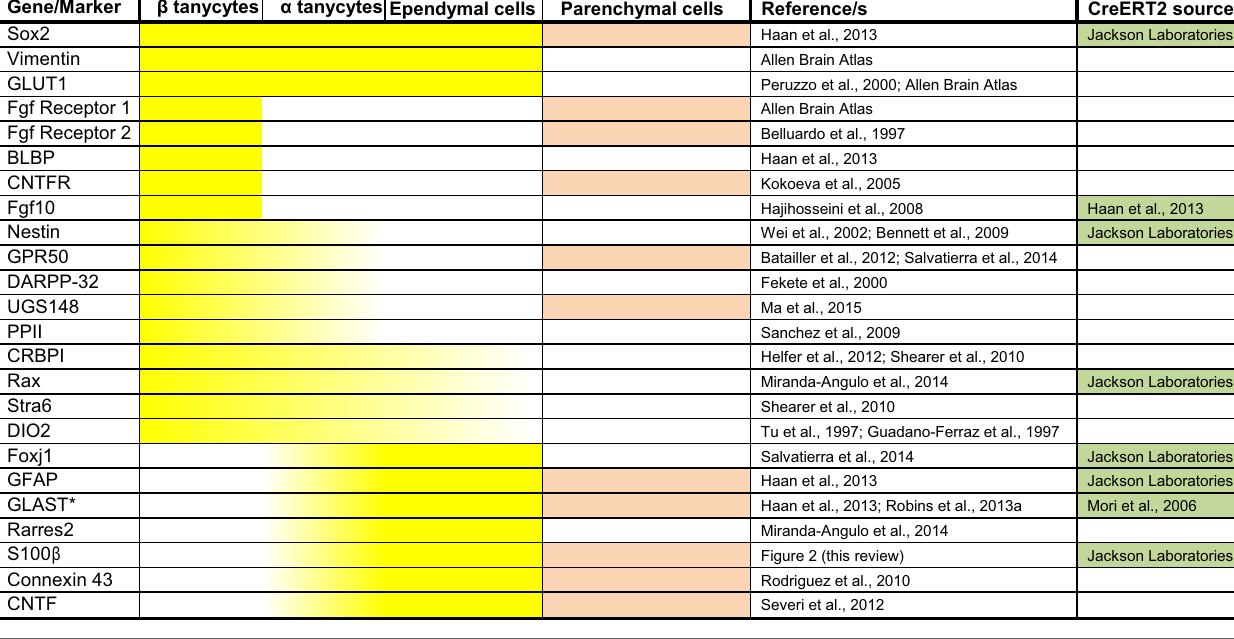
TABLE 1 | Common and domain-restricted gene expression within the cell lining of the adult third ventricle.